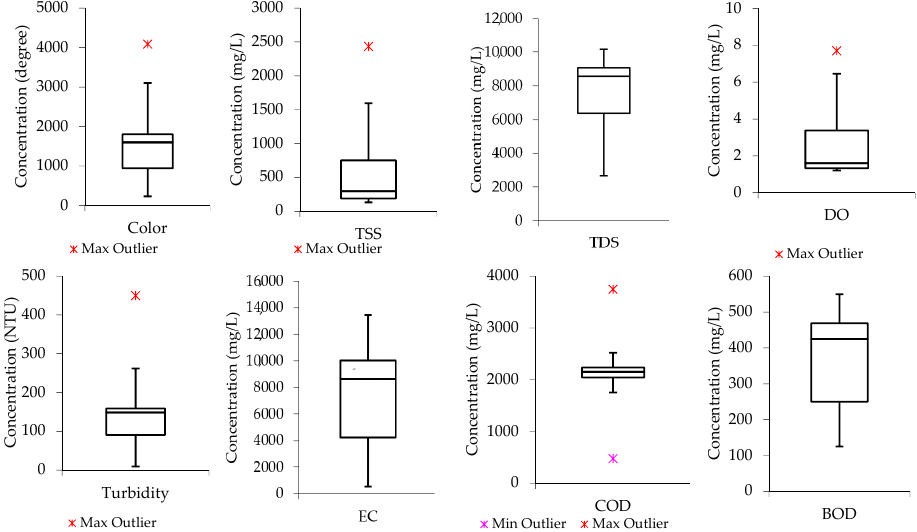
Figure 1. Data distribution from the raw wastewater samples for color, TSS, TDS, DO, turbidity, EC, COD, and BOD.